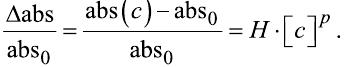
Table 2: Constants k and n determined according to the proposed pro- cessing of the experimental data. NH 3 concentration